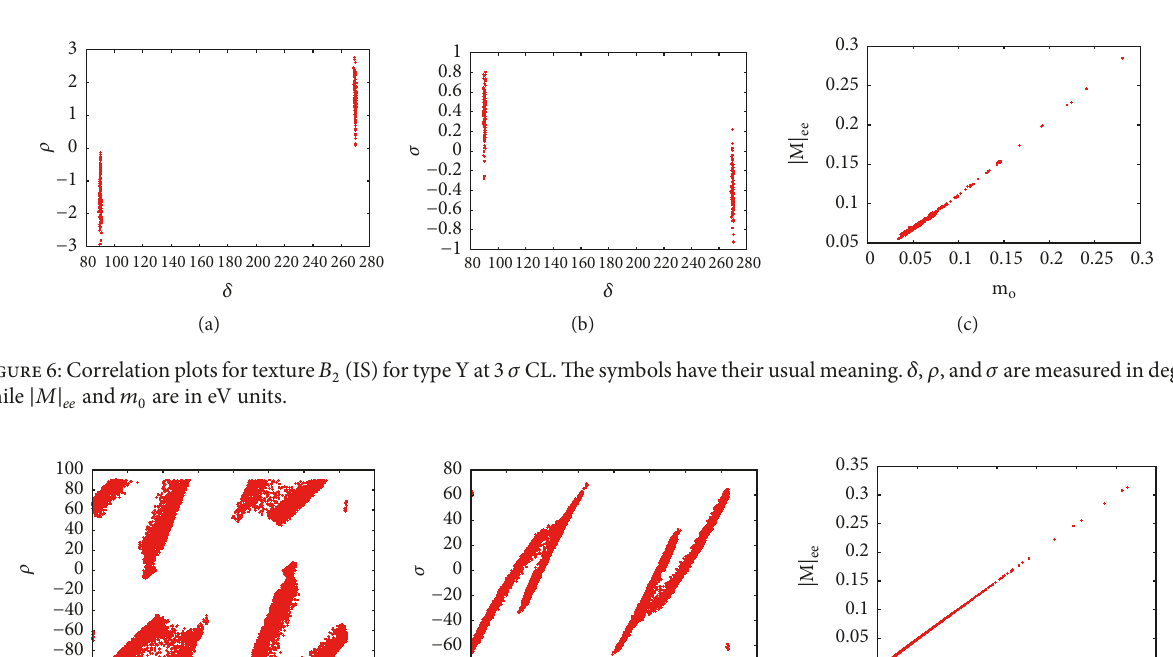
Figure 5: Correlation plots for texture 𝐵 2 (NS) for type Y at 3 𝜎 CL. The symbols have their usual meaning. 𝛿,𝜌 , and 𝜎 are measured in degrees, while |𝑀| 𝑒𝑒 and 𝑚 0 are in eV units.